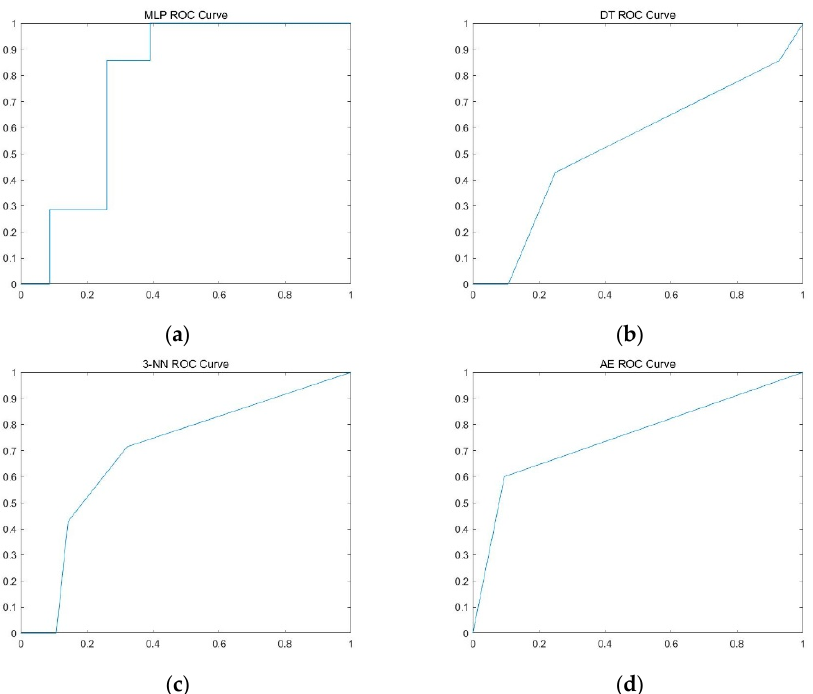
Figure 3. ROC curve using preoperative parameters: ( a ) Multi ‐ layer perceptron, ( b ) decision tree, ( c ) KNN, and ( d ) auto ‐ encoder.